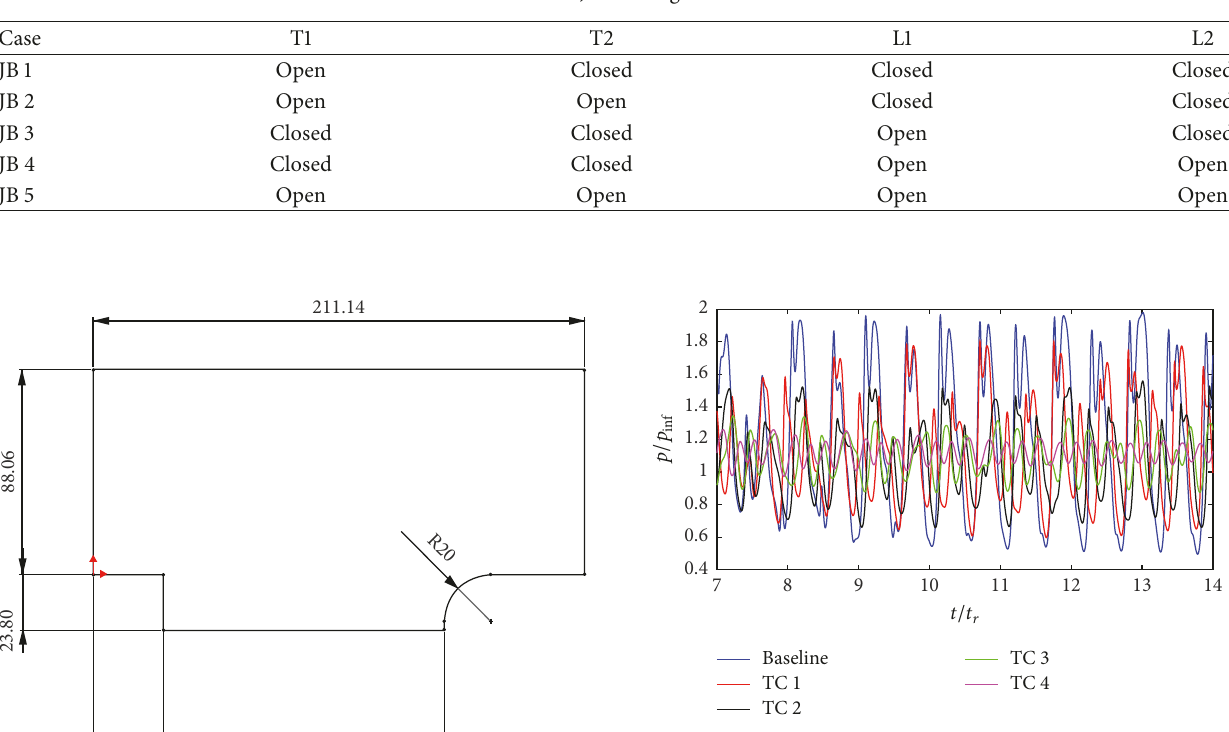
Figure 23: Density contours for baseline and trailing edge wall modification cases ( 𝑡/𝑡 𝑅 = 0.55 ) (a) baseline, (b) TWM 1, (c) TWM 2, and (d) TWM 3. Table 6: Jet blowing cases.